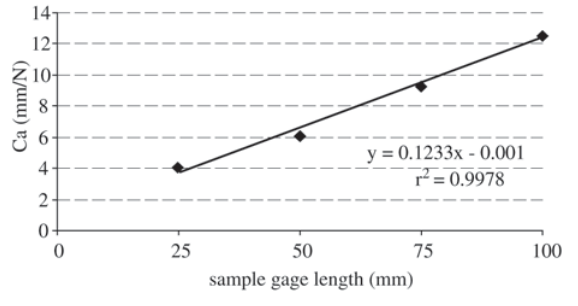
Figure 6. Graphical plot for the system (testing equipment) com- pliance for carbon fibres.